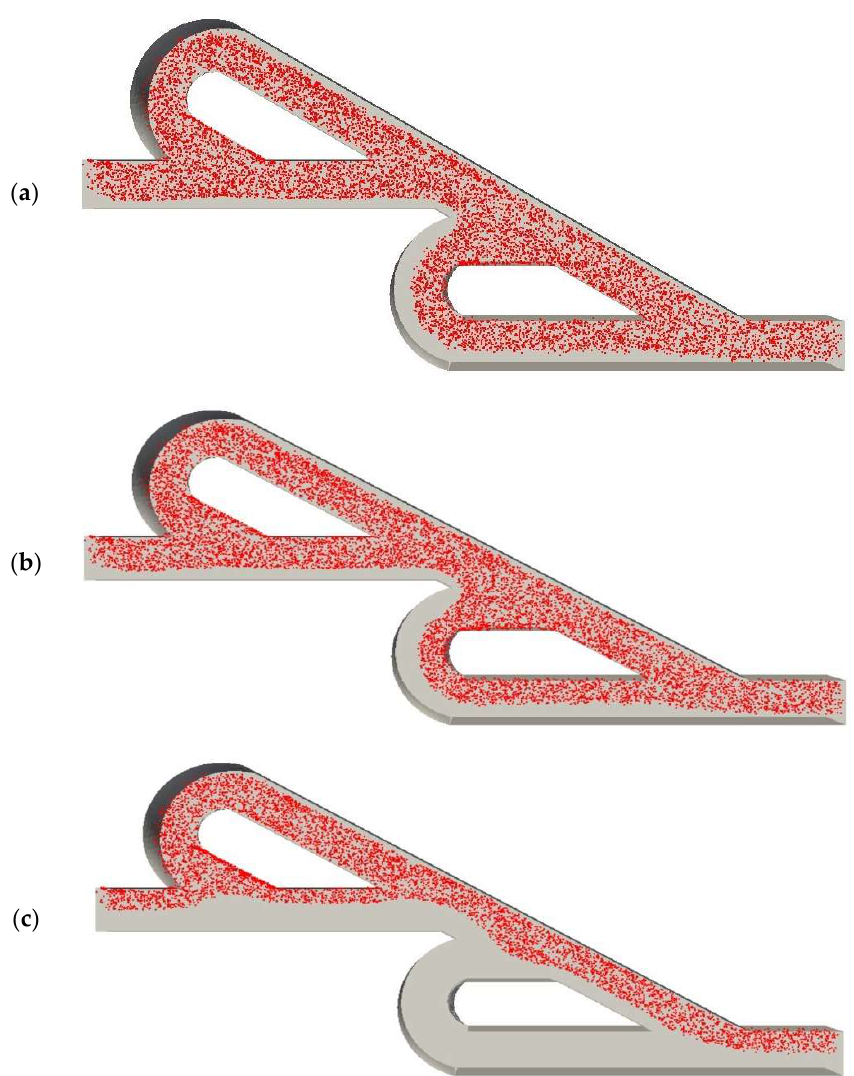
Figure 3. Distribution of nanoparticles (diameter = 13.5 nm) in the micromixer for a rate equal to 1000 nanoparticles per second under ( a ) V p /V c = 20, ( b ) V p /V c = 10, and ( c ) V p /V c = 1.